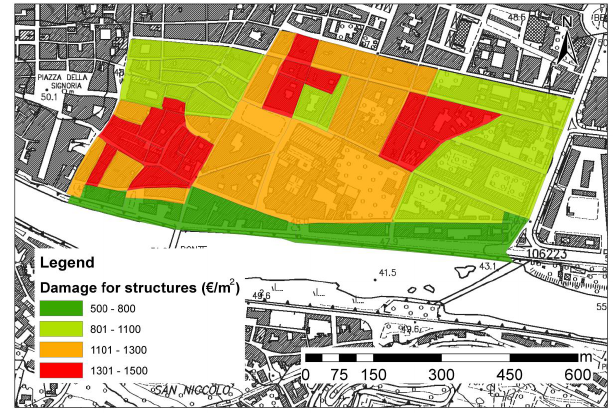
− 2 ) for the 200yr